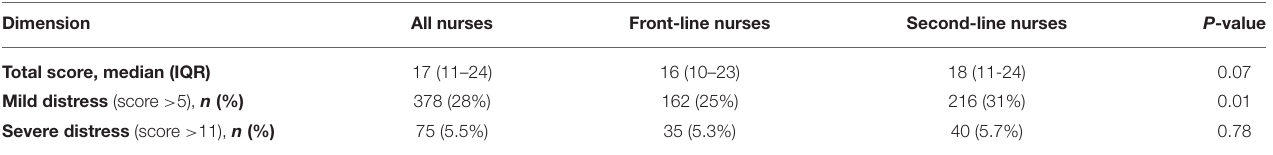
TABLE 8 | Scores on the Chinese version of the general health questionnaire-28 for identifying minor psychiatric disorders completed by 1,364 Chinese nurses during the COVID-19 pandemic. Dimension All